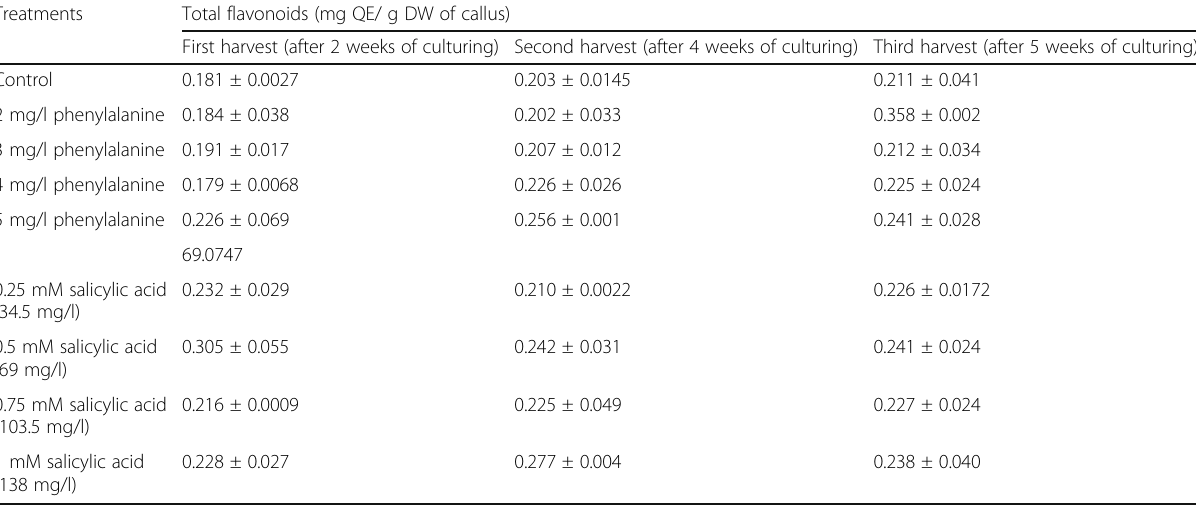
Table 2 Total flavonoids in gardenia calli cultures cultured on MS media contained different concentrations of phenyl alanine or salicylic acid during the three harvested periods of culturing